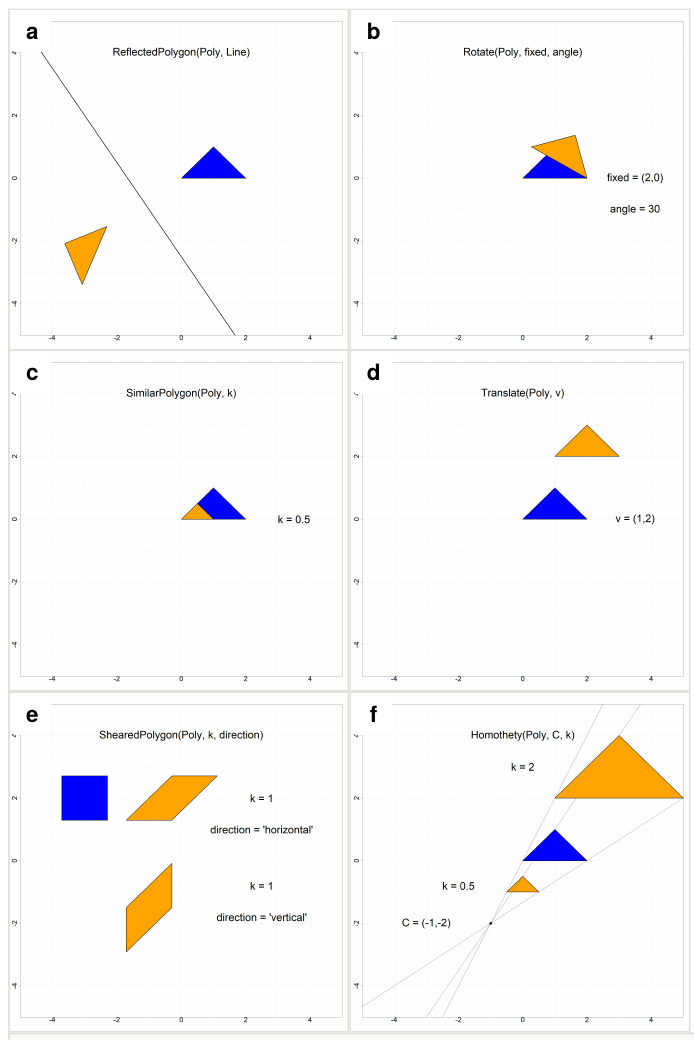
Examples of use of the functions included in the package that represent a ffi ne transformations in the plane. In all the pictures, the blue triangle, placed at the points A(0,0), B(2,0) and C(1,1), is the one passed to each of the functions, being the orange triangle the output resulting for each of the